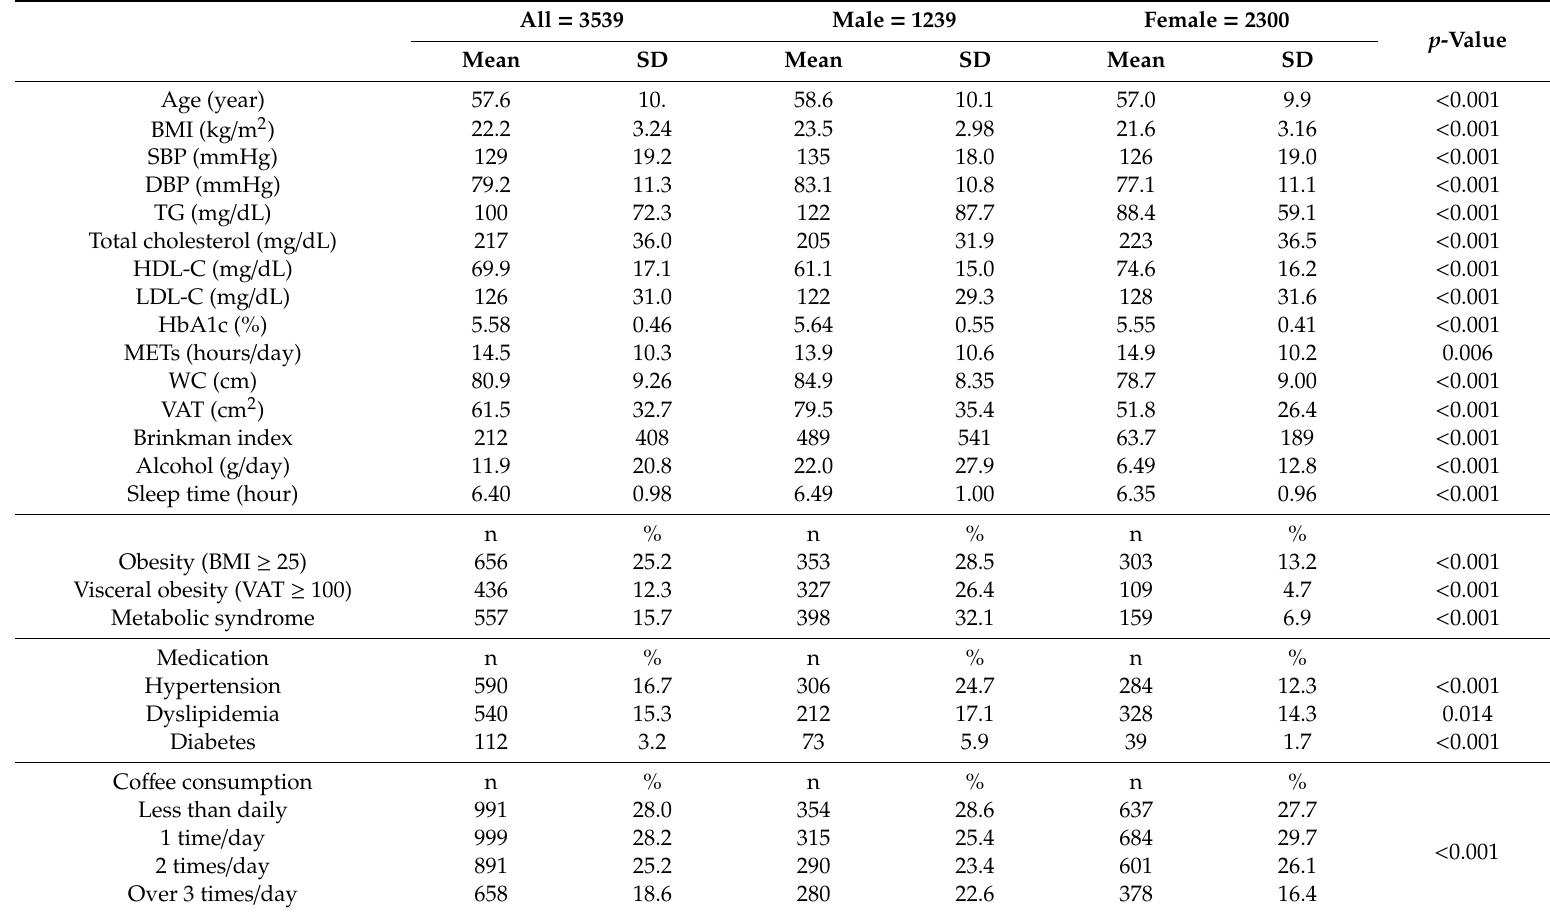
Table 1. Characteristics of